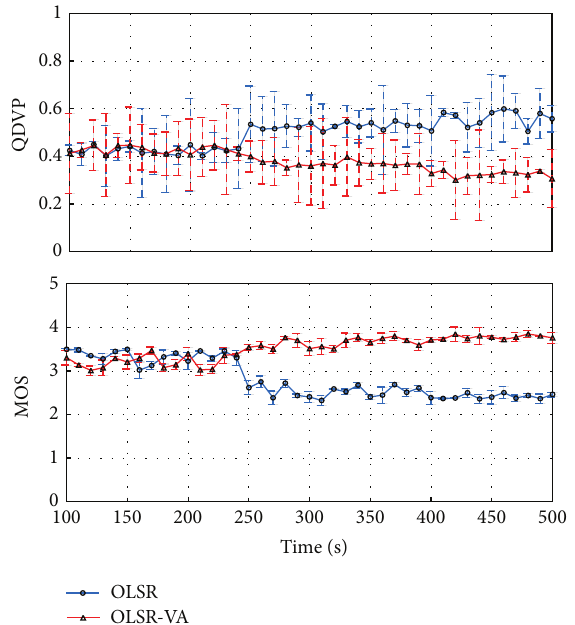
Figure 6: QDVP and MOS as a function of simulation time in scenario “1.”